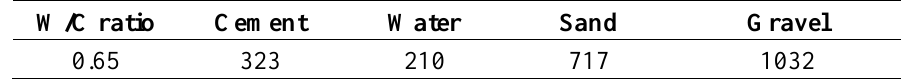
Table 1. Concrete mix of test specimens (unit: kg/m 3 ).